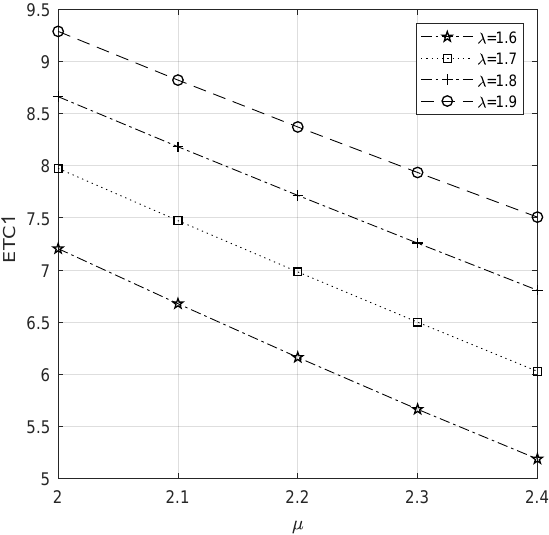
Figure 6. The impact of ETC when λ vs θ for WSAM.